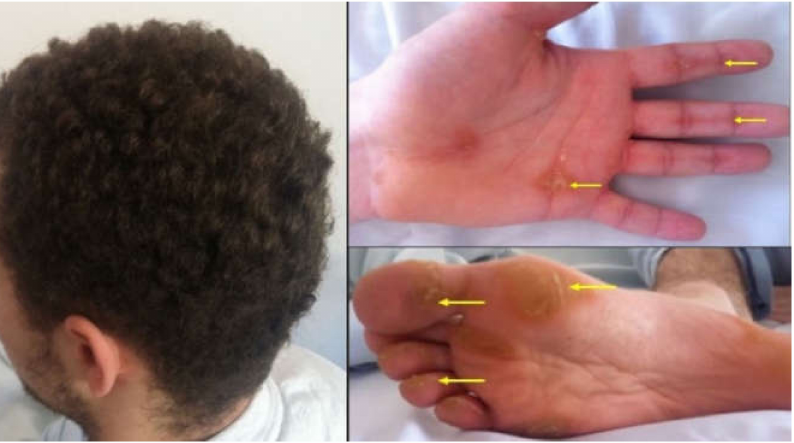
Figure 1. The patient has woolly hair, characterized by the fact that the hair is curly and dull. Striated fibrous palmar hyperkeratosis—hyperkeratotic lesions are located on the fingers and flexion areas (arrows). Focal plantar hyperkeratosis—hyperkeratotic lesions are located in the pressure zones (arrows).